Question: Summarize what this figure shows in one sentence.
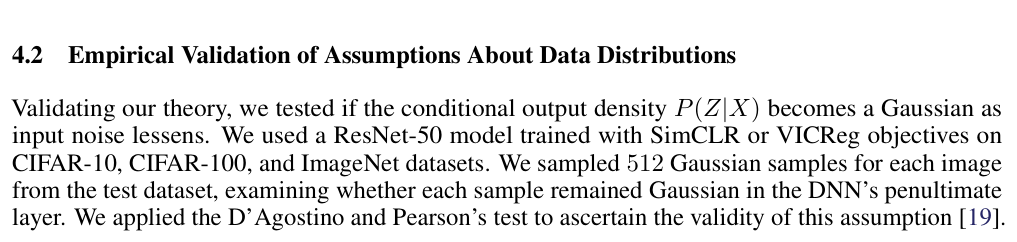
Answer: (left) displays the p-value as a function of the normalized std. For low noise levels, we reject that the network’s conditional output density is non-Gaussian with an 85% probability when using VICReg. However, the network output deviates from Gaussian as the input noise increases.